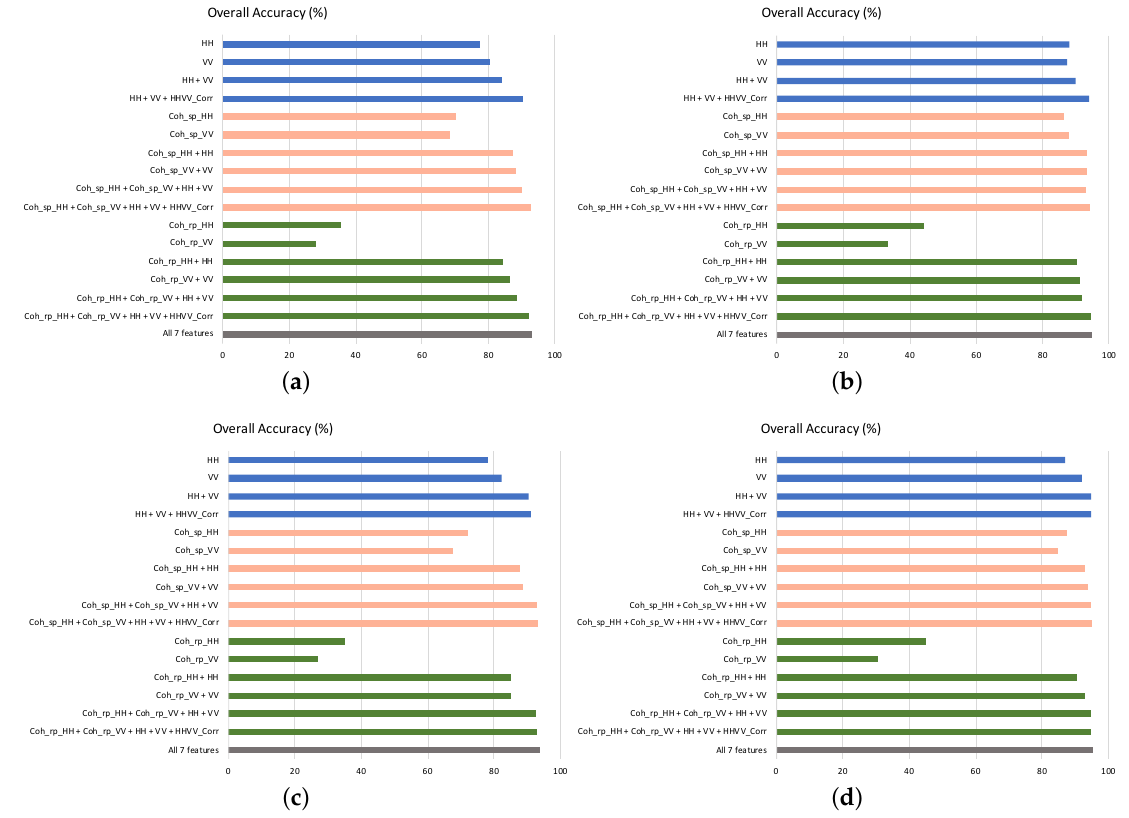
Figure 9. Graphical representation of the OA values obtained by all sets of input features. Bar colour: blue for polarimetric features, pink for single-pass interferometric coherence features, green for repeat-pass interferometric coherence features, and grey for all features. ( a ) Pixel level. HH and VV channels. ( b ) Field level. HH and VV channels. ( c ) Pixel level. Pauli channels. ( d ) Field level. Pauli